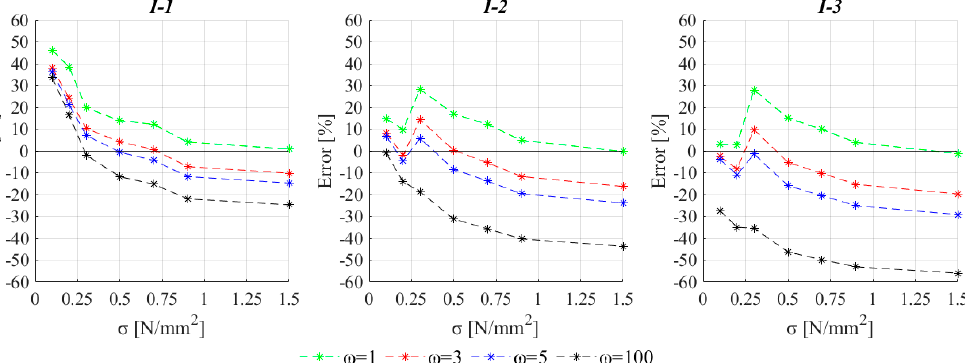
Figure 14. Average percentage error on the estimate of the axial load, considering its variation along the analysis up to d top = 6.75 mm, for the examined I-shaped 3D assembly, as a function of average vertical stress.